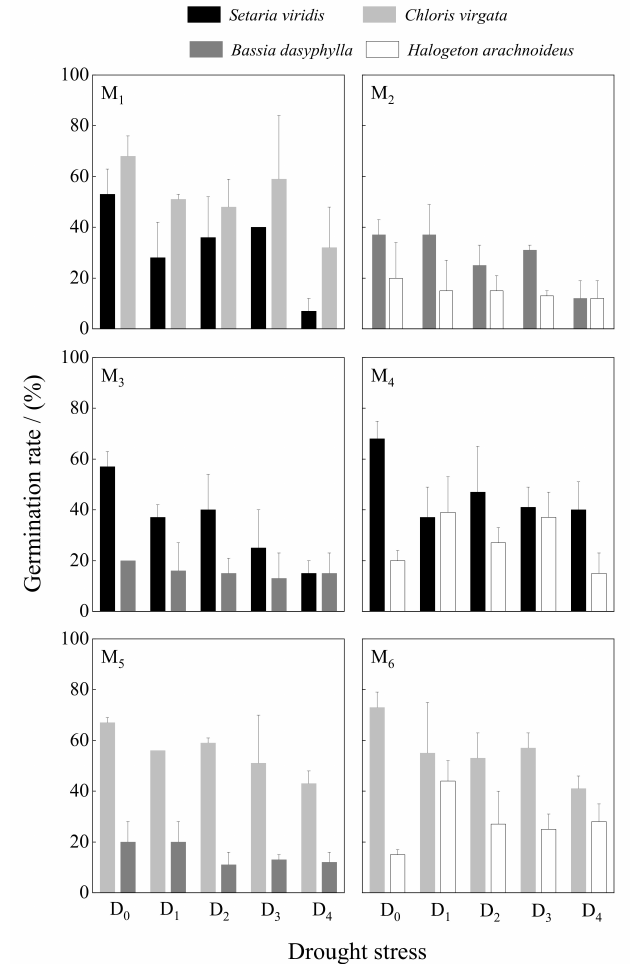
Figure 1. Response of the germination rate of four annual desert plants to the interaction of drought and mixed sowing (D0–D4 represents five drought stress gradients, and D0–D4 represents PEG-6000 solution with different concentrations simulating different drought stress gradients, respectively: control 0% (D0), mild drought 2% (D1), moderate drought 5% (D2), moderate and high drought 10% (D3), and severe drought 15%